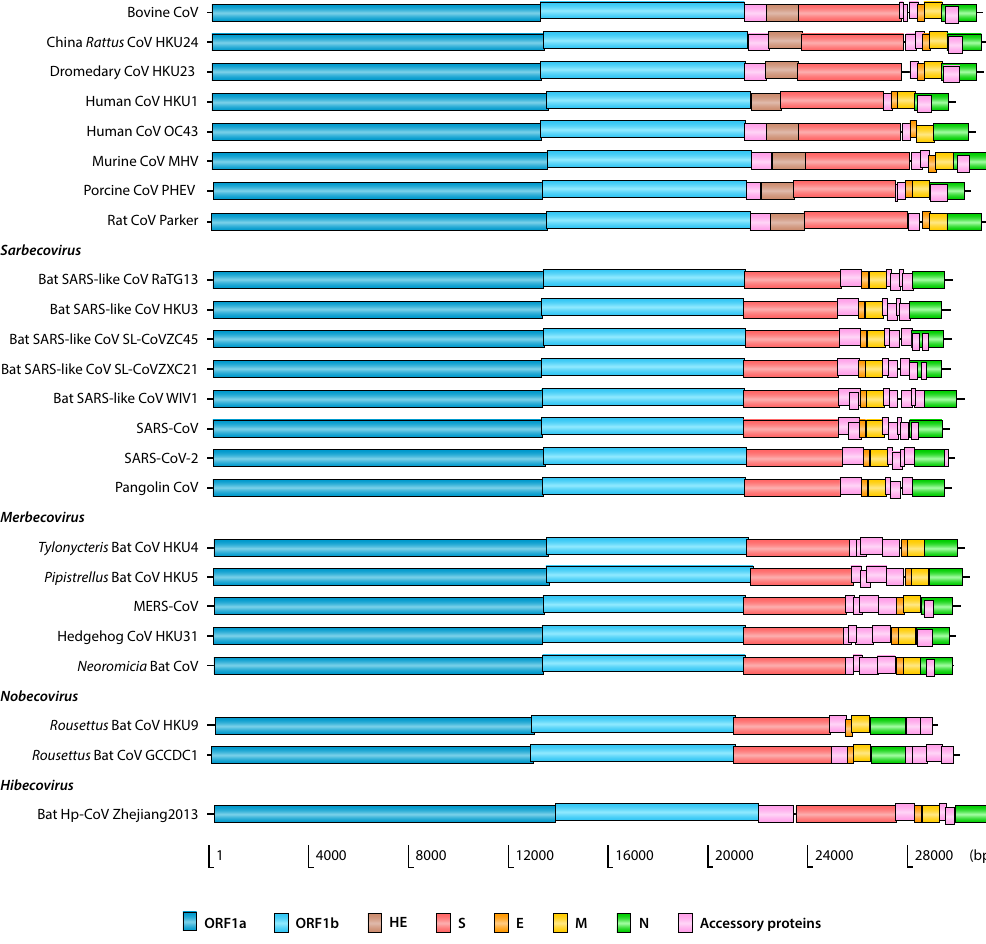
Figure 1. Organization of betacoronavirus genomes. Name abbreviations are provided in Table